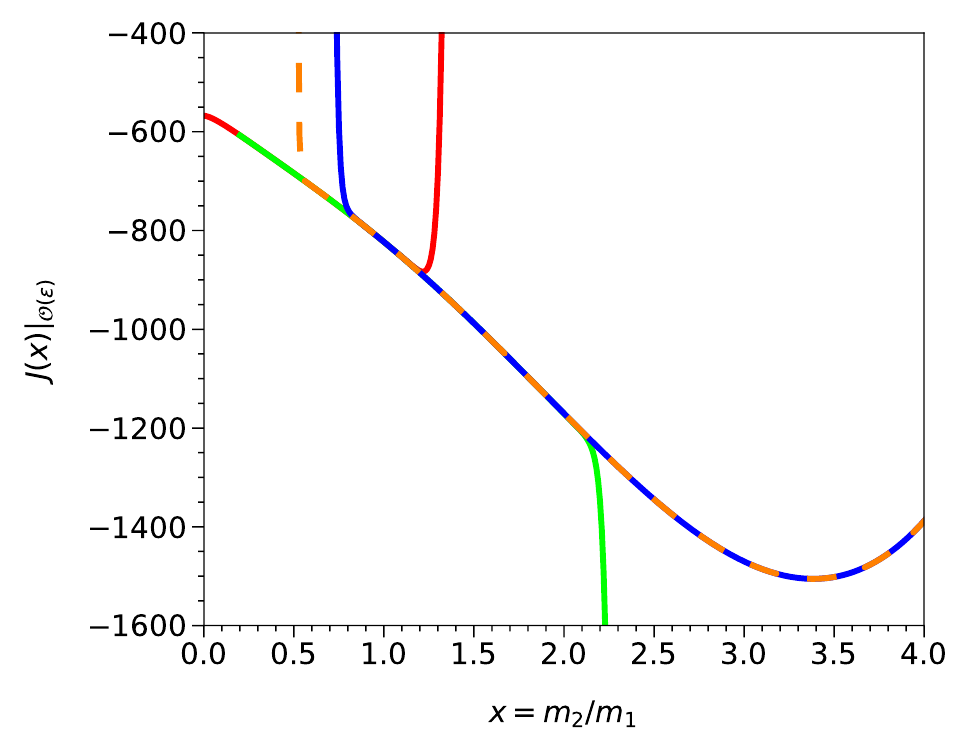
Figure 3: O ( ε ) term of the integral J . The solid red, green and blue curves cor- respond to the expansions in x , 1 − x and 1 / x . For the dashed orange curve the expansion parameter 1 − 1 / x has been